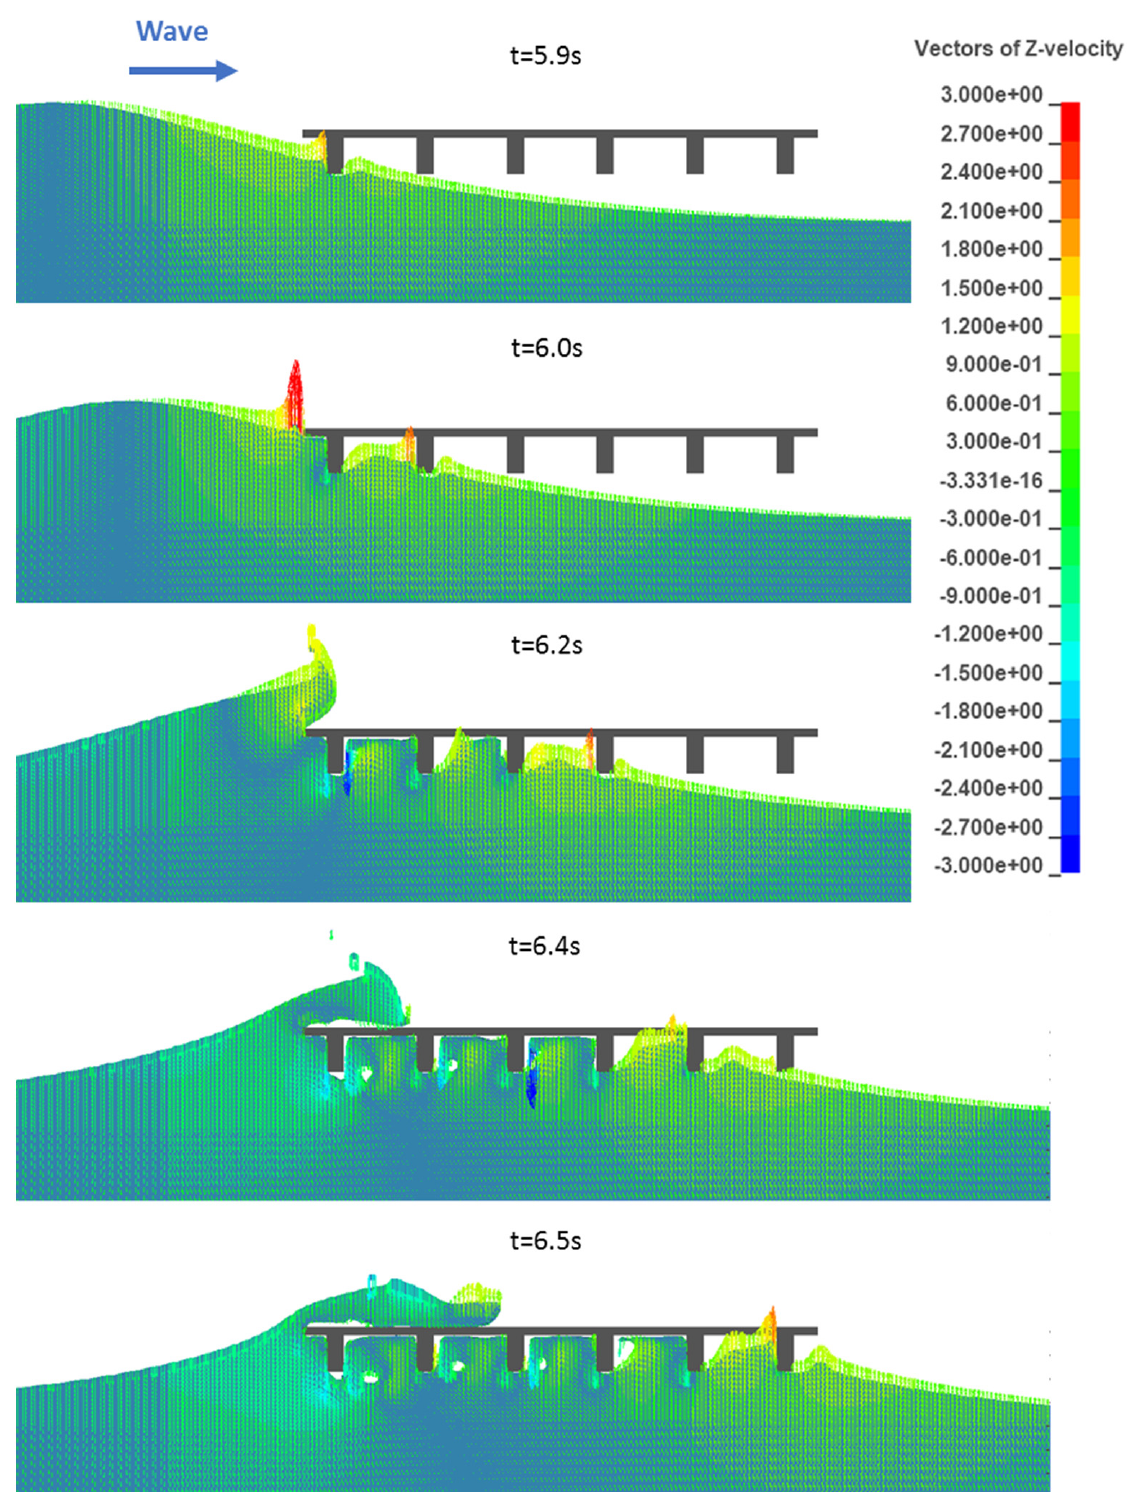
Figure 19. Vectors of z-velocity during the impact of wave SW3 ( H = 0.68 m) on the 150% L deck .